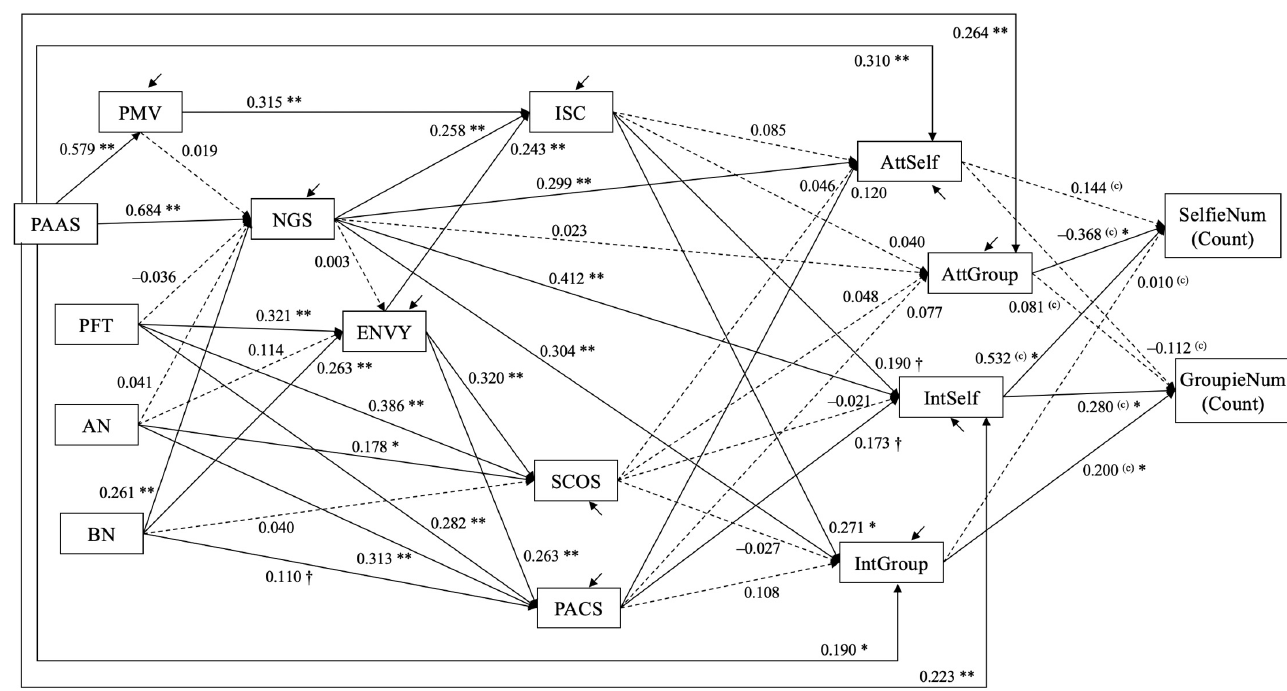
Figure 10. Study 3: Estimated structural equation model (Model II-2, N = 357). Unstandardized estimates are shown. Dashed line depicts path coefficients for which p > 0.10; † p < 0.08; * p < 0.05; ** p < 0.01. The variables SelfieNum and GroupfieNum were treated as count variables with negative binomial distribution. The coefficients on the count variables (marked with superscript “(C)”) indicate the difference in the log of the count response. The following covariances are allowed in the model but not shown in the figure: perceived mating value (PMV) and three eating disorder variables (PFT, AN, BN) are allowed to covary with one another; the residuals for intrasexual competition (ISC) and social comparison (SCOS, PACS) are allowed to covary with one another; the residu-